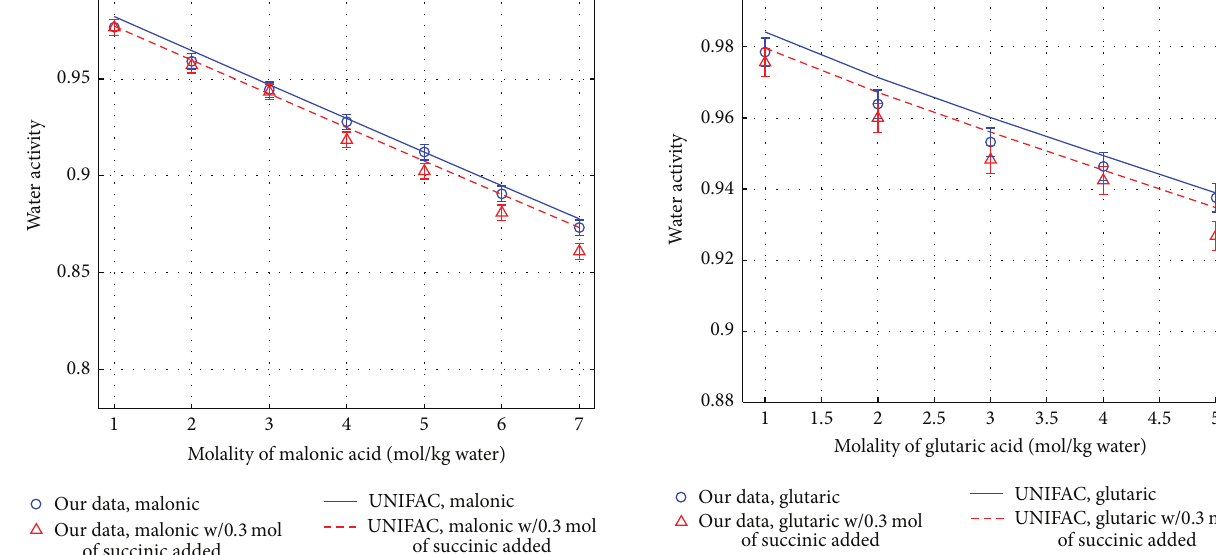
Figure 4: Water activity of malonic acid with and without succinic acid added. Each data point represents the average of 4 replicate measurements; error bars on measured data represent standard deviation of 0.4%.